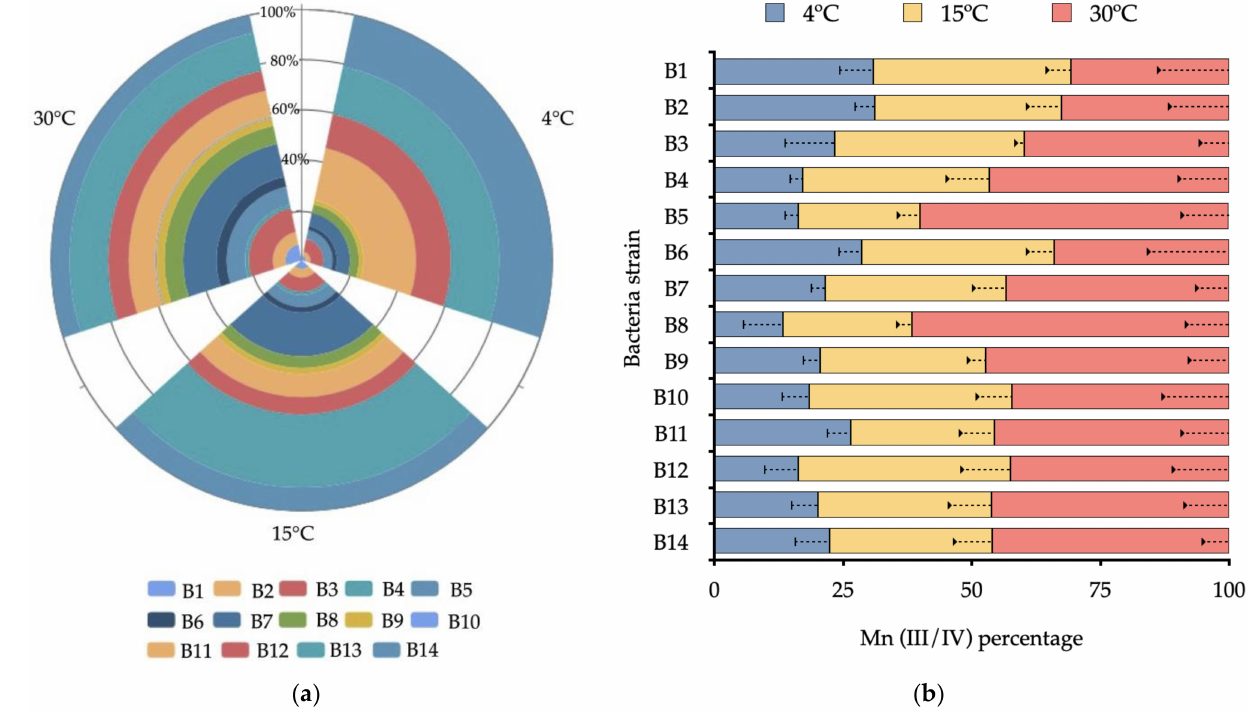
Figure 3. ( a ) Accumulated bacterial growth kinetics (at OD 600 nm) at 4 ◦ C, 15 ◦ C, and 30 ◦ C from 24 to 120 h. ( b ) percentage of Mn(III/IV) produced from 24 to 120 h at 4 ◦ C, 15 ◦ C, and 30 ◦